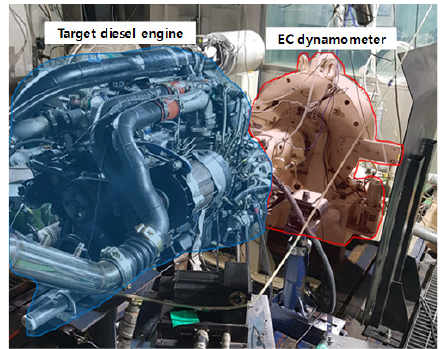
Figure 1. 300 hp diesel engine.